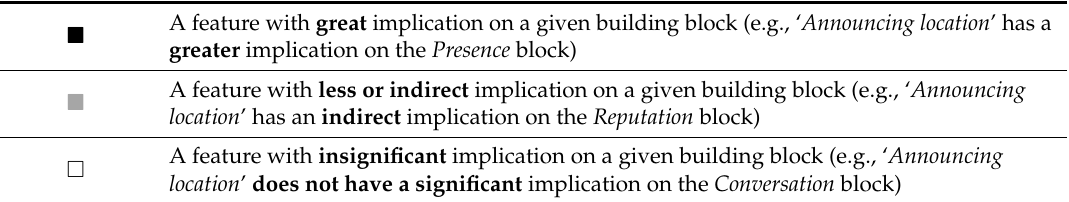
Table 3. Implications on the COPE.er building